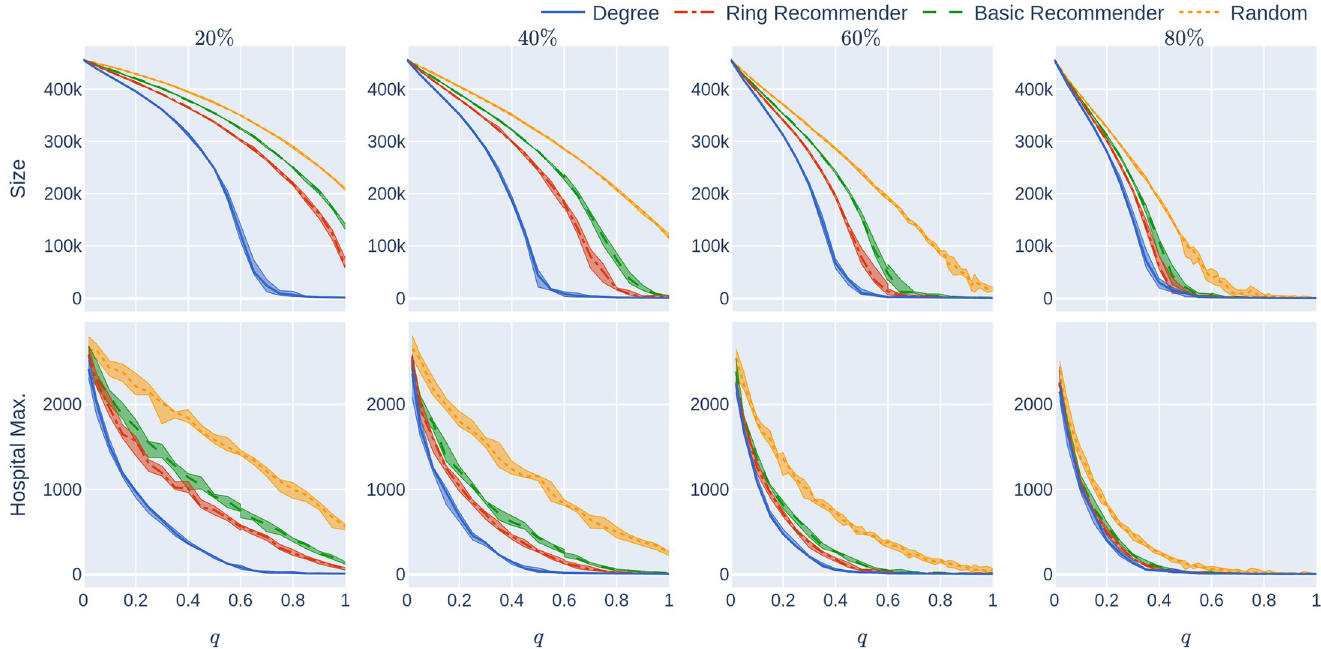
Fig 9. Experiment 2 on a geometric network with not too many super-spreaders: Influence of the quarantine strictness q for various uptake percentages p % and the four uptake scenarios at infection rate β = 0.05. The underlying network is a 500,000-node GIRG with τ = 3.3 (fewer super-spreaders) and α = 2.3 (more geometric). Each column represents an uptake percentage. The x -axis shows the quarantine strictness q varying from 0 to 1 at step size 0.05. Simulations are done for the 21 values of q corresponding to these steps. There is an additional simulation point at 0.02 (in order to avoid division by 0 in the computation for HMax and still have a point close to 0). The y -axis shows the corresponding value of the KPI. The curves in each figure correspond to the different uptake scenarios, as labelled. For each parameter value, the plotted result is the median over 5 runs. The shaded region around the plot covers the results of all 5 simulations. The epidemic is started by infecting 100 individuals, chosen uniformly at random. Simulation is halted when there are no more exposed or infected vertices.